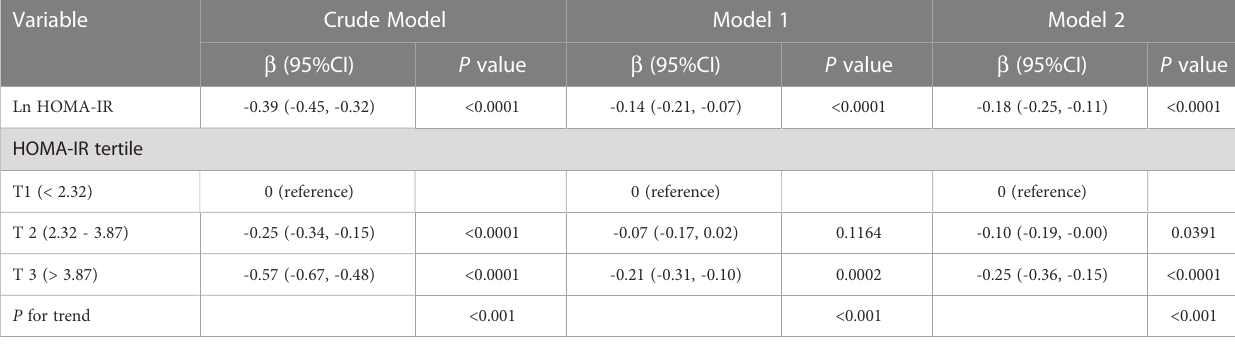
TABLE 2 Multivariate linear regression for association of Ln HOMA-IR with Ln OSI.